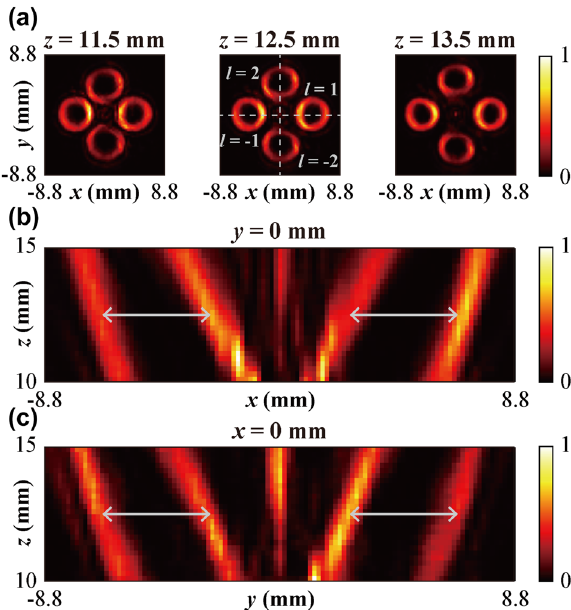
Figure 5: Four-channel Q-PVBs generation with topological charges of l = − 1, 1, 2, − 2 at 0.75 THz. (a) Measured electric field intensity distributions of focused Q-PVBs carrying the topological charges of l = − 1, 1, 2, − 2. The chosen distance of x - y plane is z = 11.5, 12.5, 13.5 mm, respectively. (b) and (c) measured normalized field intensity profiles of y = 0 mm plane and x = 0 mm